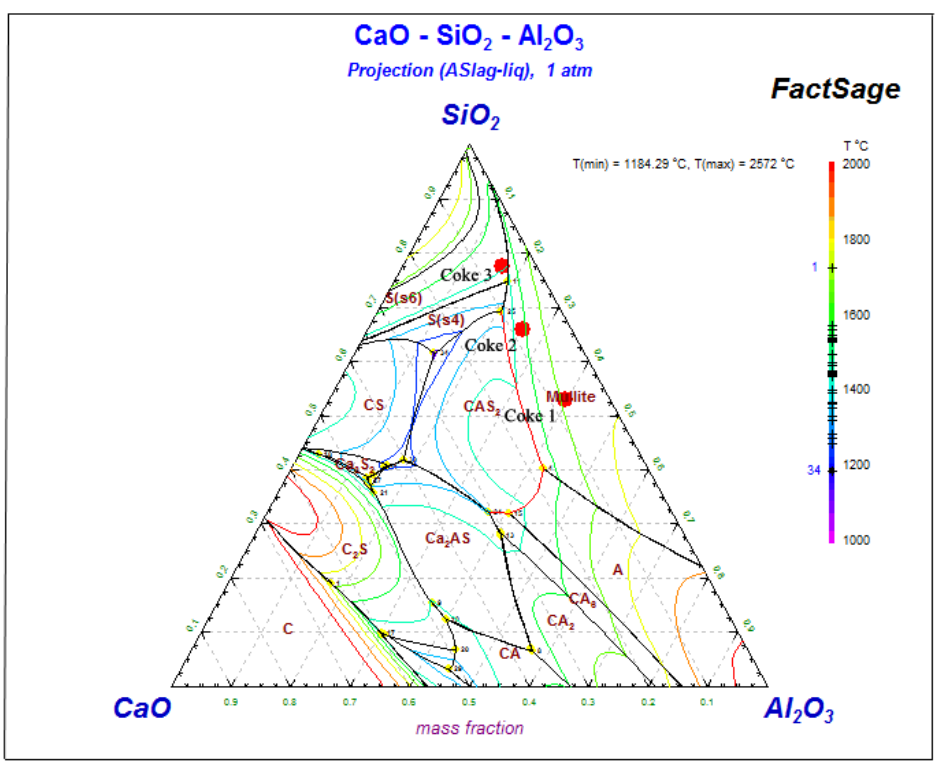
Figure 10. CaO-SiO 2 -Al 2 O 3 slag system phase diagram of unreacted coke samples.